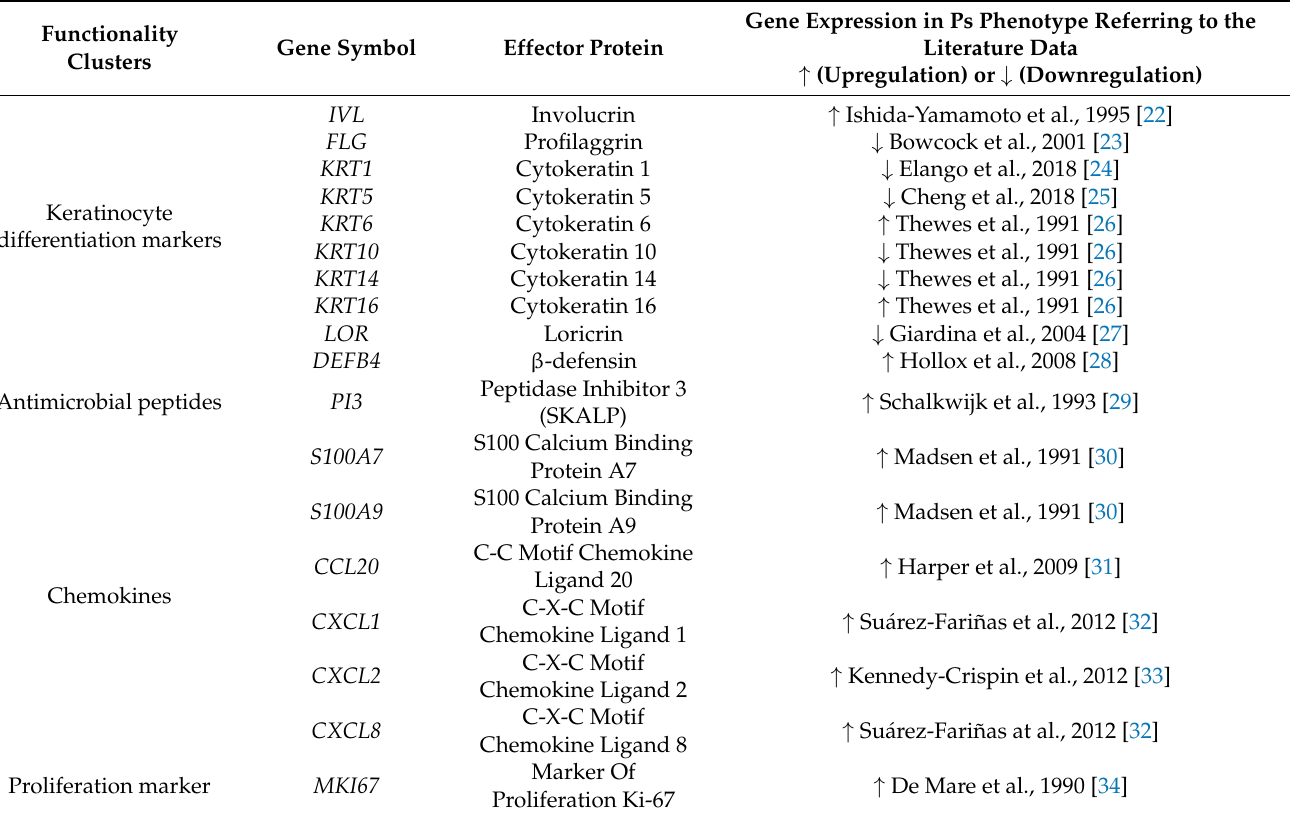
Table 1. Gene markers designated for the establishment of in vitro psoriasis (Ps)-like inflammation models with cytokine mix (5MIX)-, imiquimod (IMQ)-, and serum-induced monoculture of HaCaT or pKC keratinocytes, and phorbol 12-myristate 13-acetate (PMA), lipopolysaccharide (LPS), and interferon gamma (IFN- γ ) co-culture of HaCaT and THP-1 cells. Gene Expression in Ps Phenotype Referring to the Functionality Gene Symbol Effector Protein Literature Data Clusters ↑ (Upregulation) or ↓ (Downregulation)